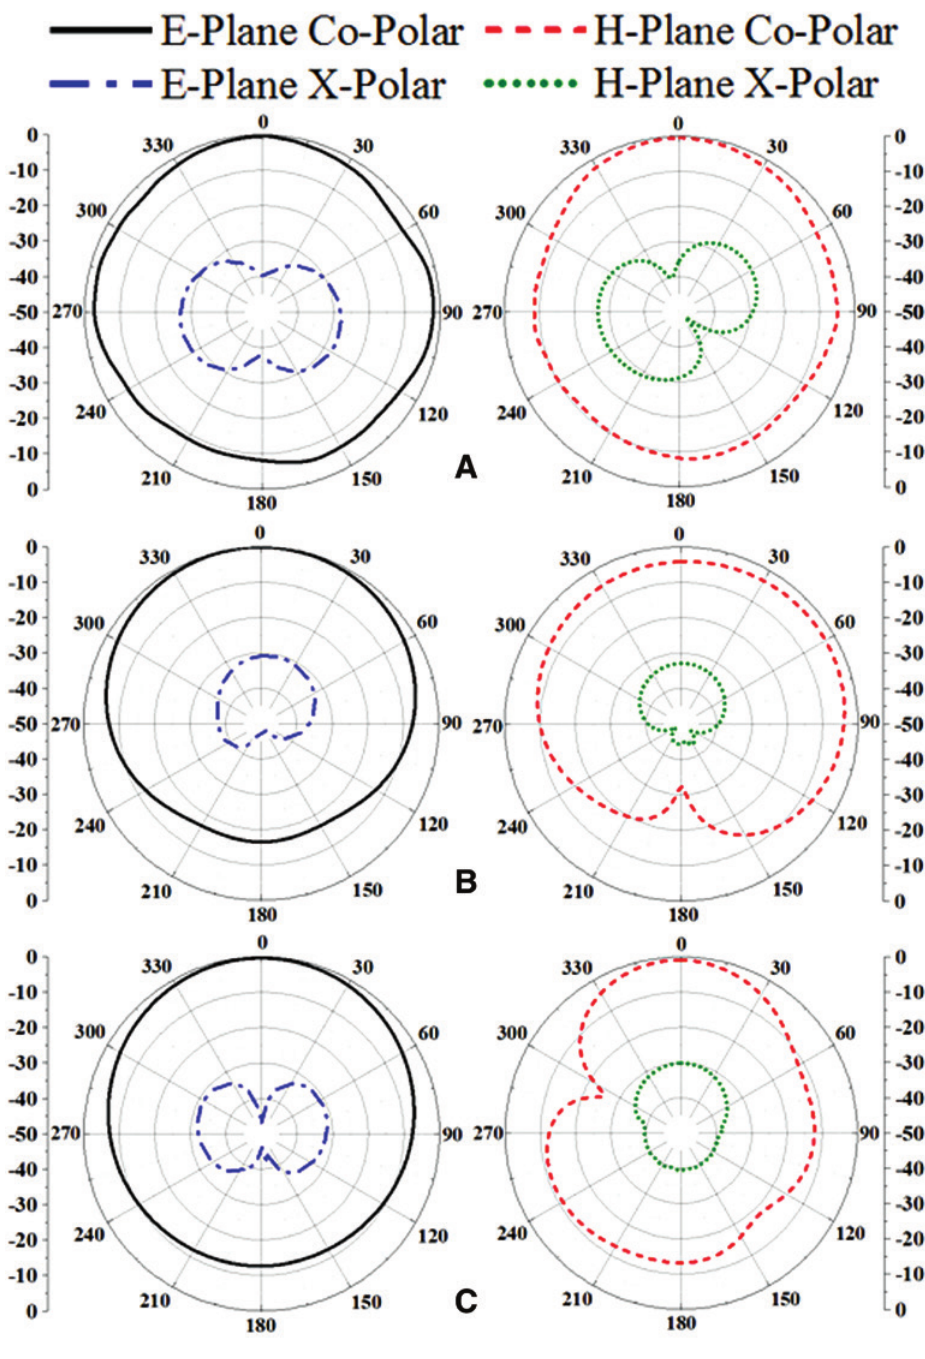
Figure 8: Normalized E- and H-plane measured radiation patterns of the proposed antenna at (A) 0.8 GHz, (B) 3.35 GHz, and (C) 8.0